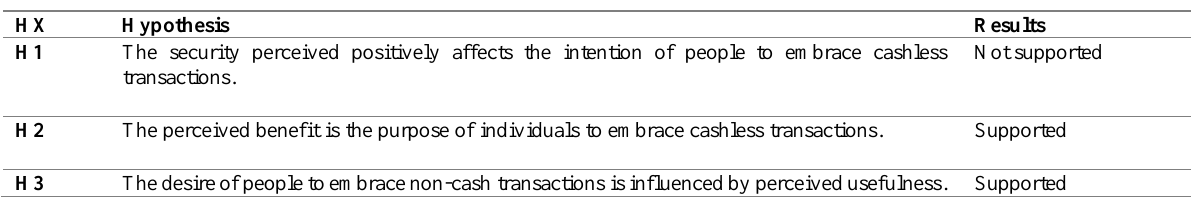
Table 10: Summary of the hypothesis testing